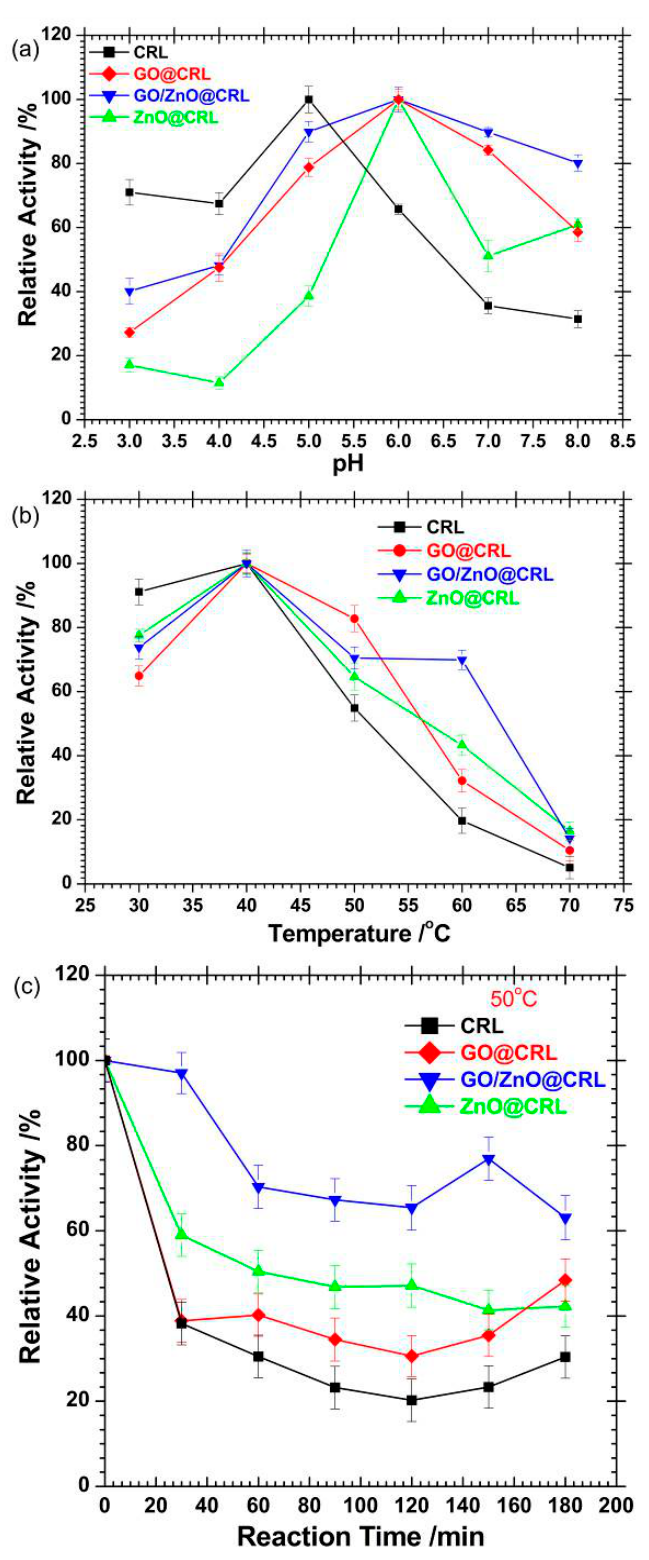
Figure 5. ( a ) Effects of the pH value on the activities of free and immobilized lipase in various pH (3.0–8.0) at 37 °C; ( b ) effects of the temperature on the activities of free and immobilized lipase at various temperatures (30–70 °C) at pH 7.0. The activity under optimal conditions was taken as control (100%); ( c ) thermal stabilities of free and immobilized lipase with various times (0–180 min) at pH 7.0 for 50 °C. The initial activity was defined 100%.